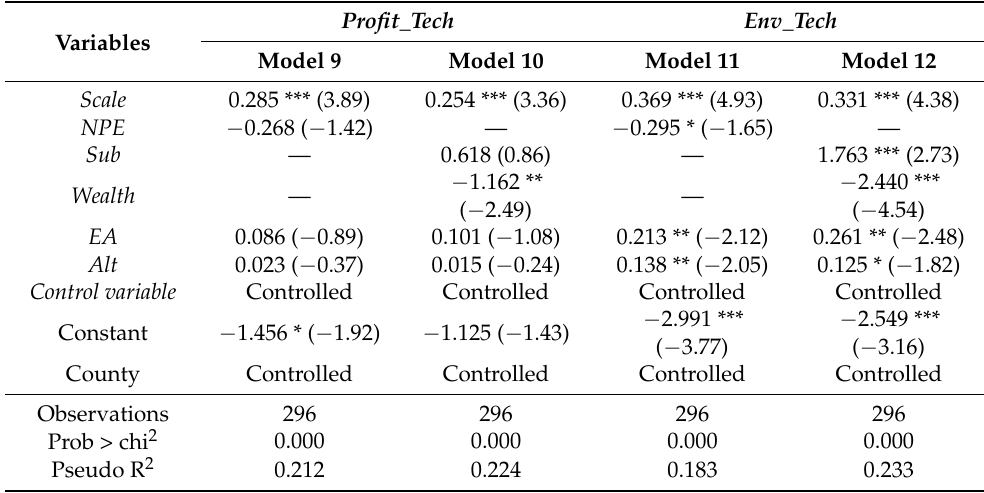
Table 4. Estimated model of the impact of Scale and NPE on Profit_Tech and Env_Tech